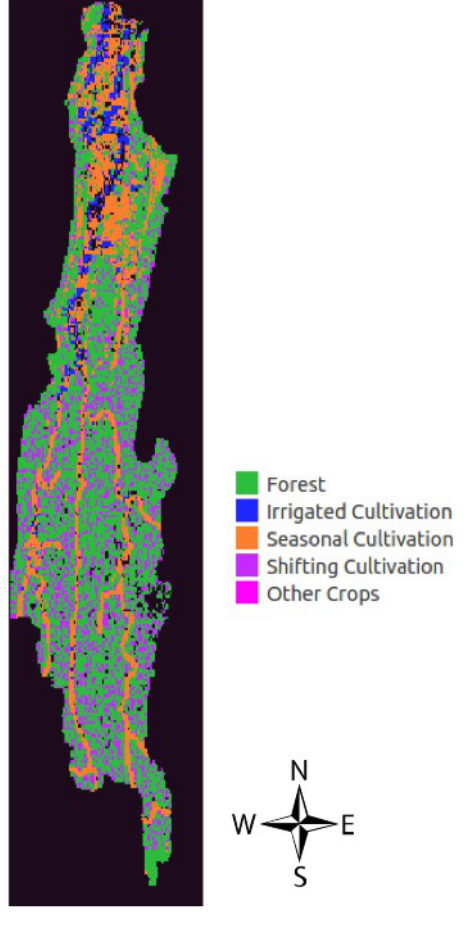
Figure 5. Land use map for 2035 when simulated with business as usual scenario for the year